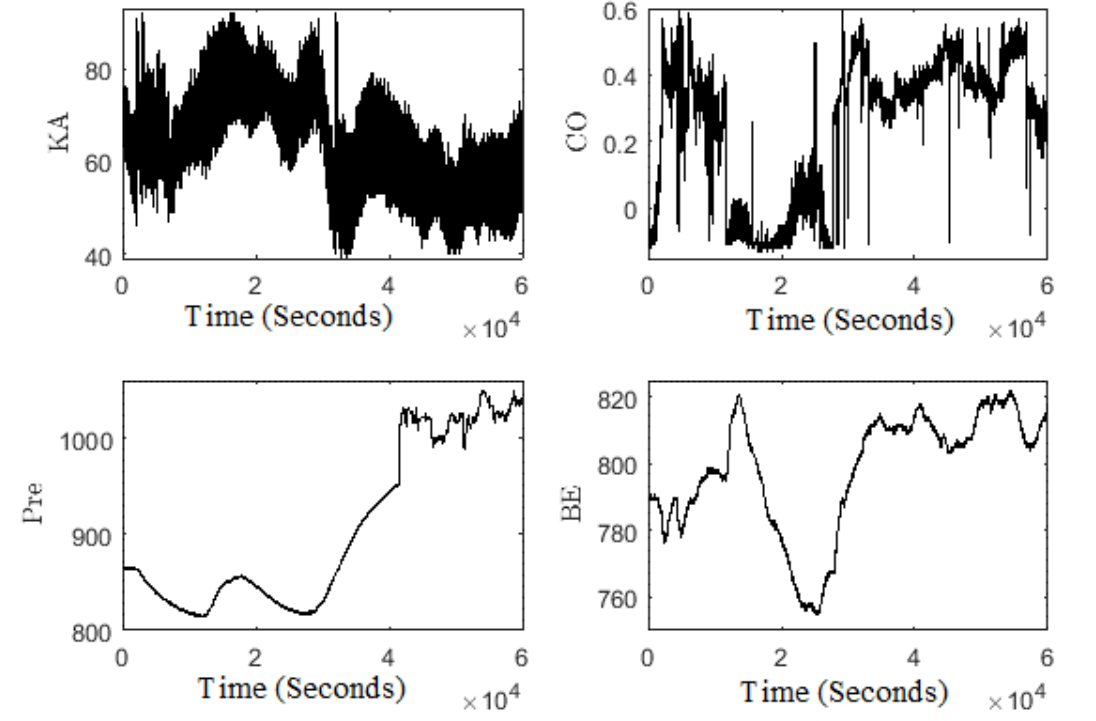
Figure 3. Outputs of CRK for seconds (collected data).